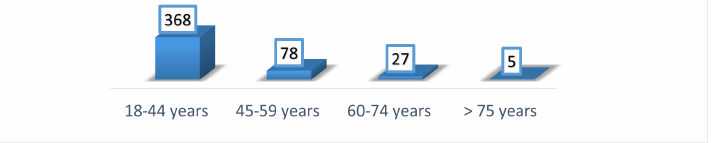
Figure 3. Distribution of victims by age